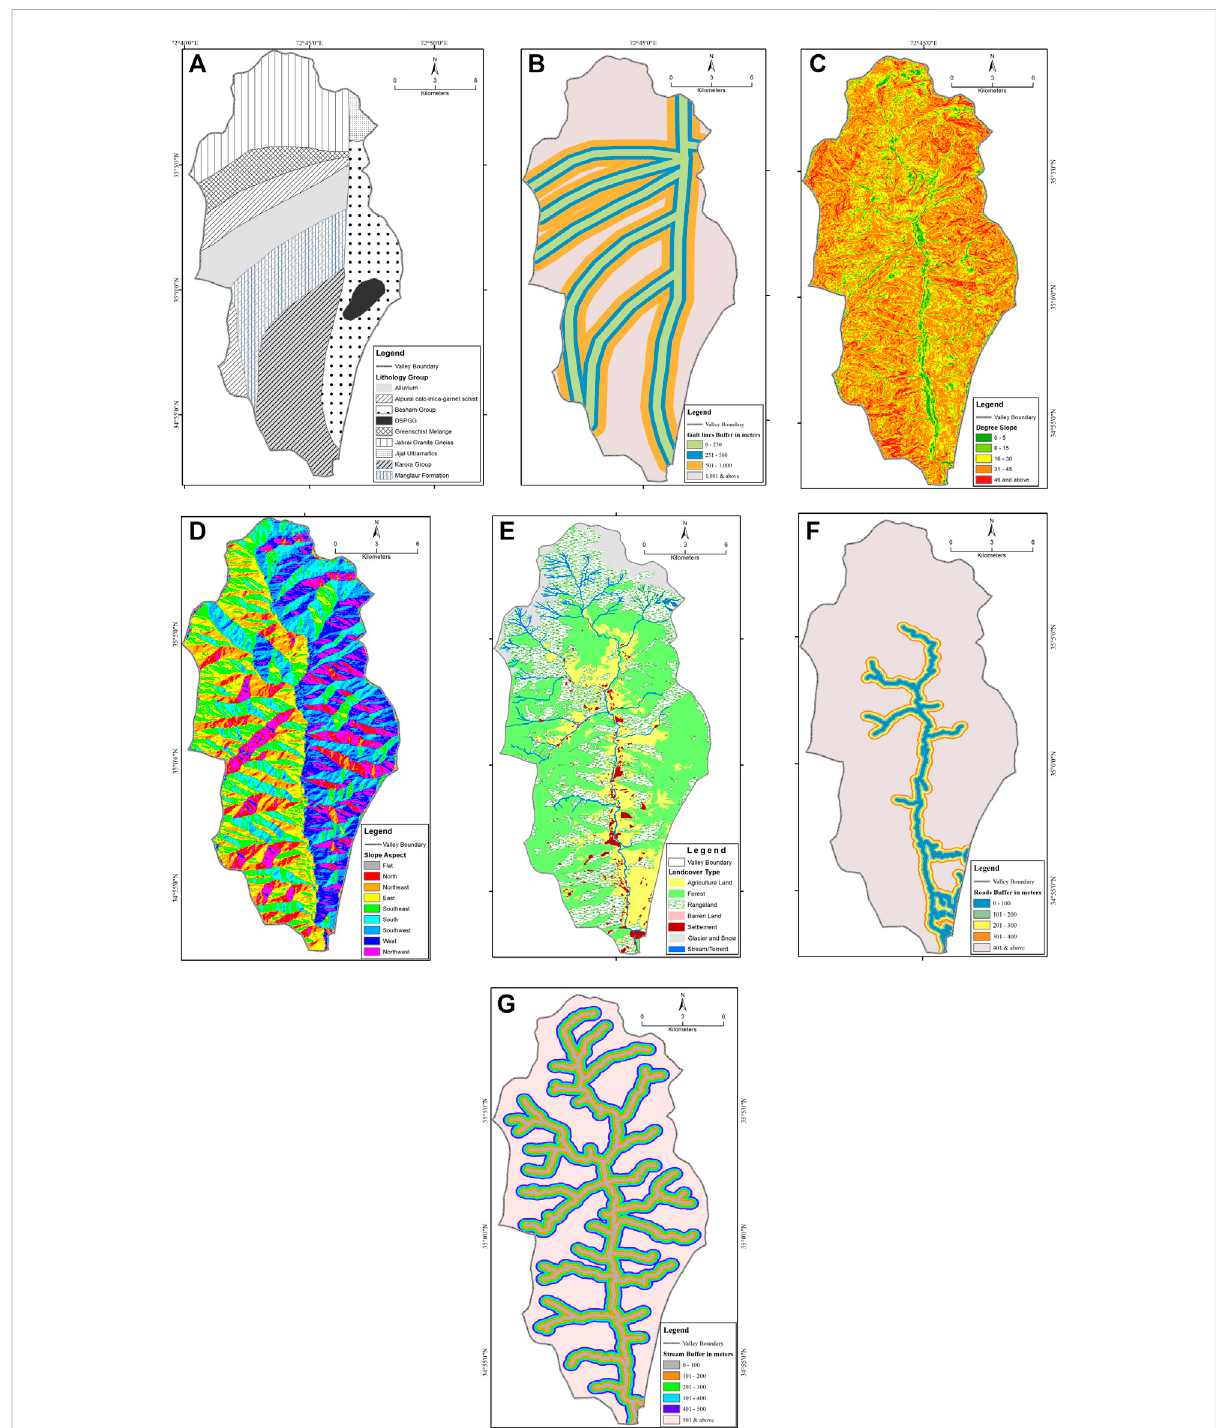
FIGURE 5 Shahpurvalley: (A) surfacegeology; (B) proximitytofaultlines; (C) slopegradient; (D) slopeaspect; (E) landuse/landcover; (F) proximitytoroad; (G) proximity to stream/torrent (Rahman et al.,